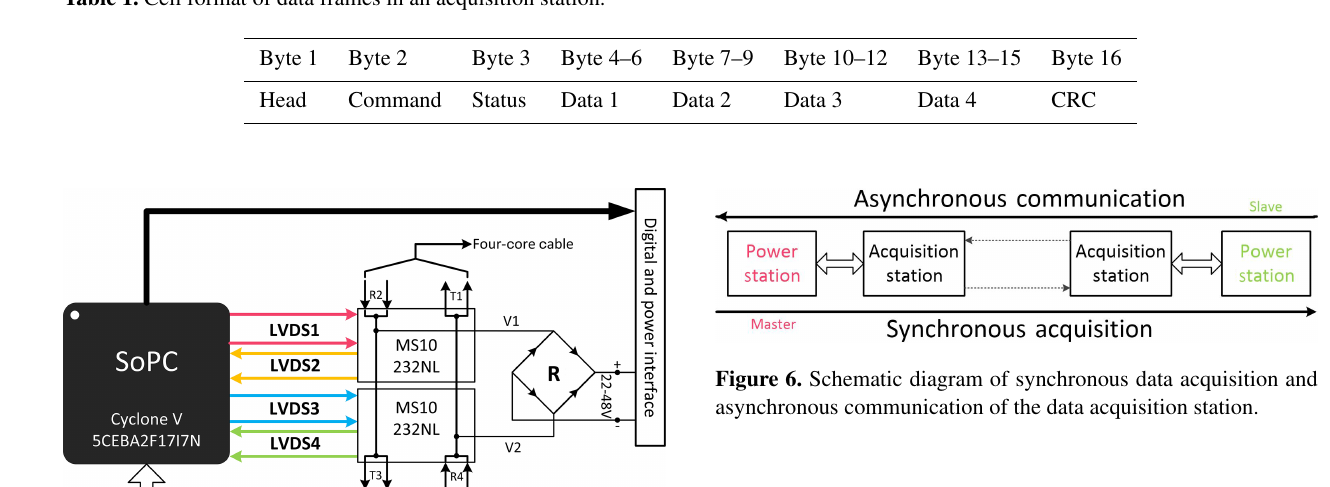
Figure 4. 50Hz filter circuit schematic. Table 1. Cell format of data frames in an acquisition station.